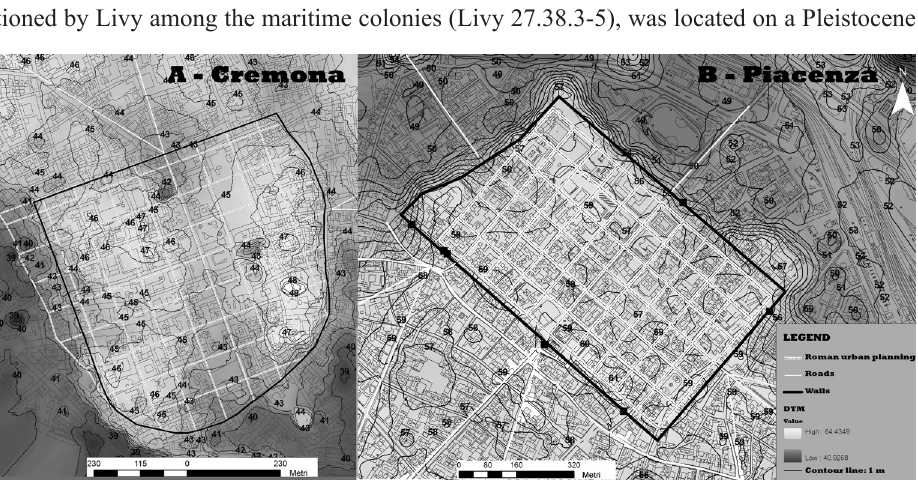
Figure 6: A: Digital terrain model of Cremona (Dall’Aglio et al. 2011a: fig. 12); B: Digital terrain model of Placentia (Dall’Aglio et al. 2011a: fig.